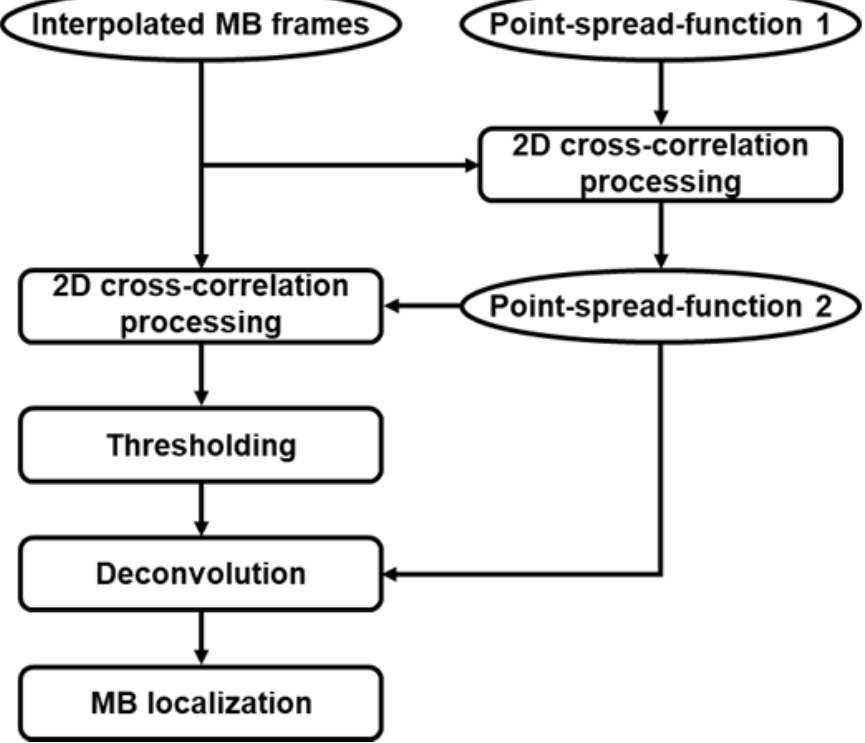
Figure 5. The part of post-processing chain for super-resolution ULM image.